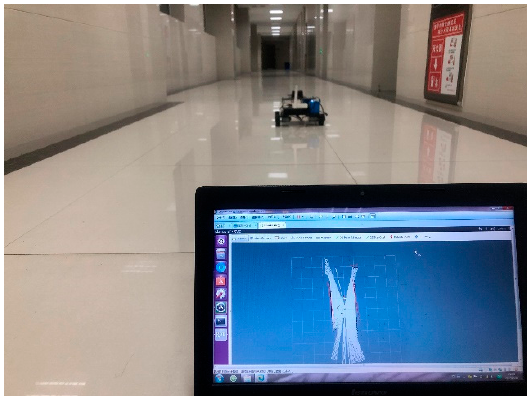
Figure 10. Map construction in a looped corridor.